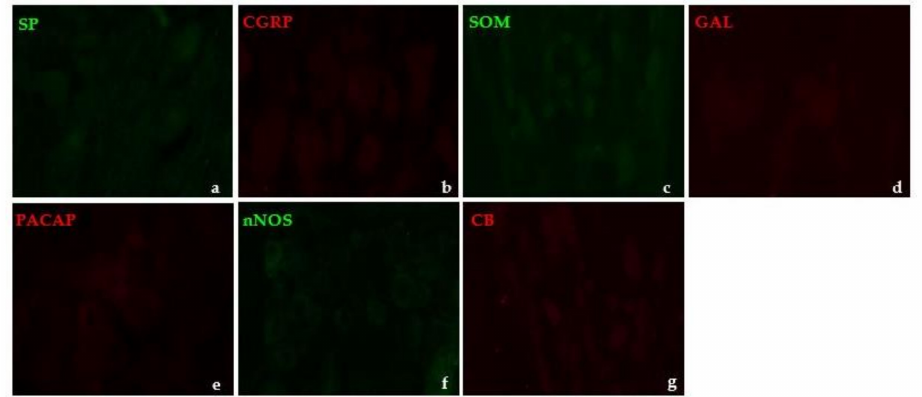
Figure 6. Representative examples of the use of immunofluorescent staining specificity control procedures: ( a , b , d , f )—omission of primary antibodies, ( c , e , g )—replacement of primary antisera by non-immune rat ( c ) or rabbit serum ( e , g